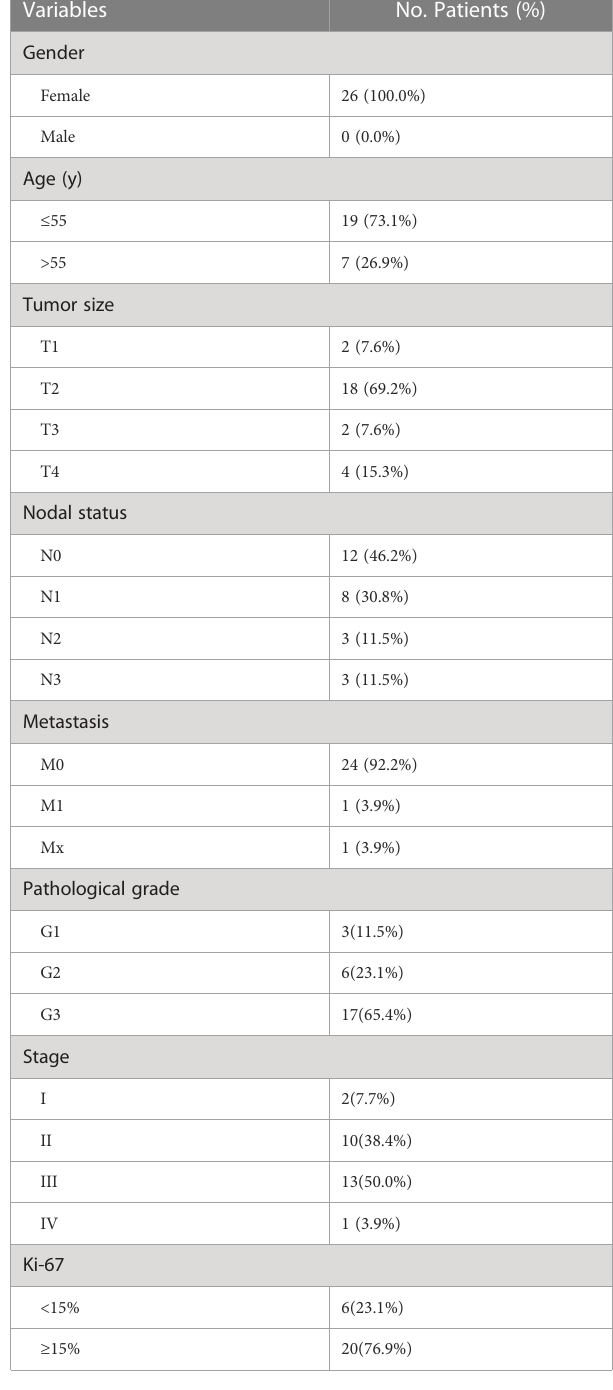
TABLE 1 Patient characteristics in TCGA and GSE47994 (n = 249 patients).